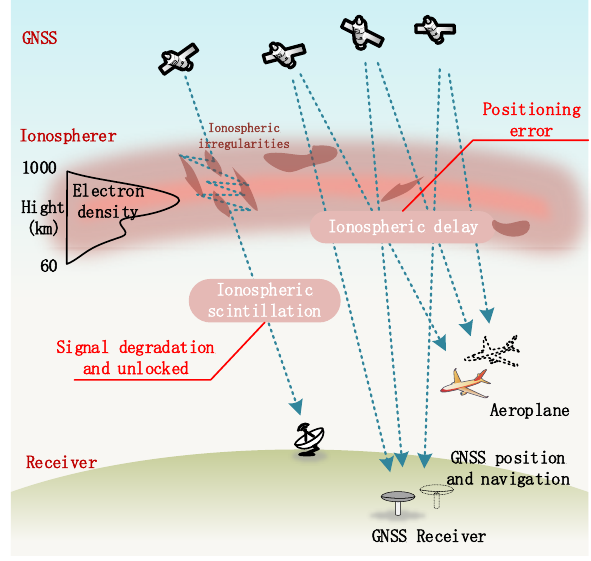
Figure 1. Ionospheric effects on GNSS signals.